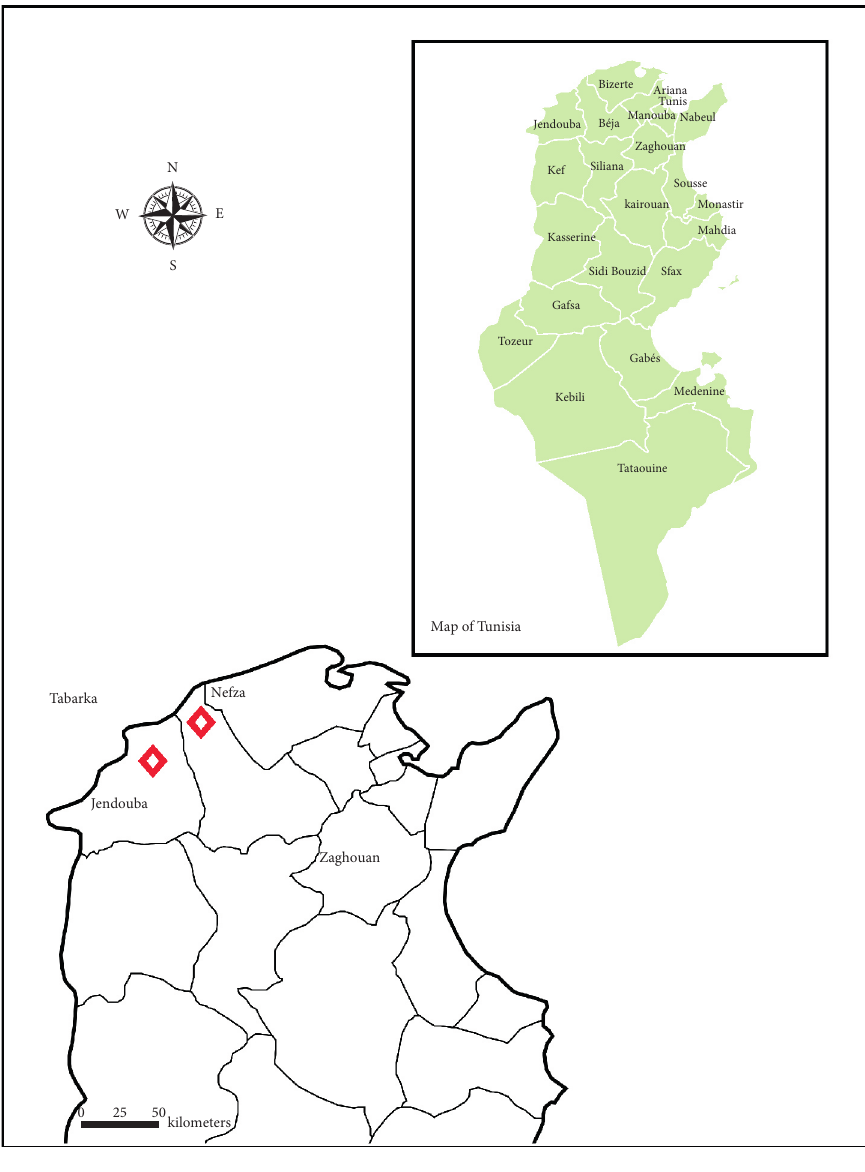
Figure 1: Location of M. officinalis sites in